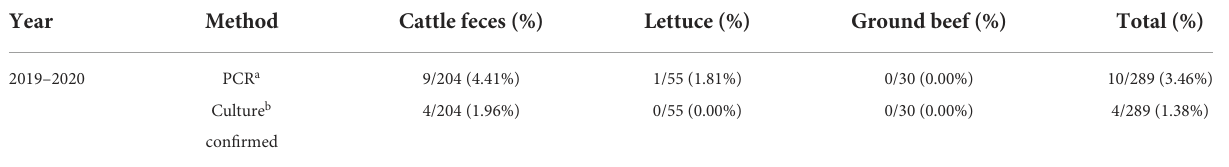
TABLE 2 Prevalence of STEC isolates in cattle feces, lettuce, and ground beef samples. Year Method